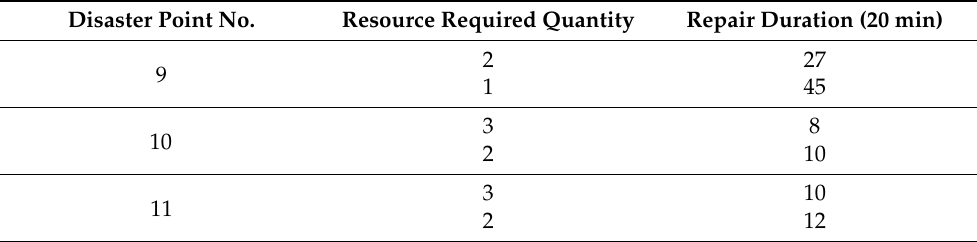
Table 9. Resource requirements and repair durations for new disaster points (Case 2). Disaster Point No.